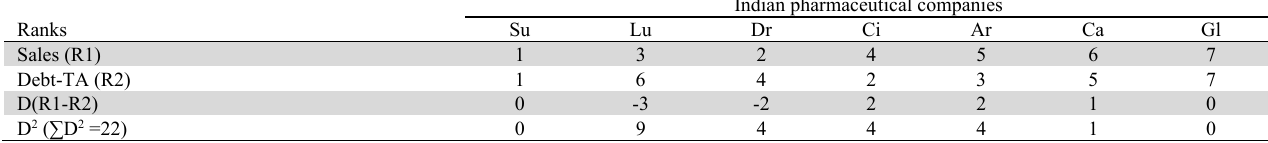
Indian pharmaceutical companies Su